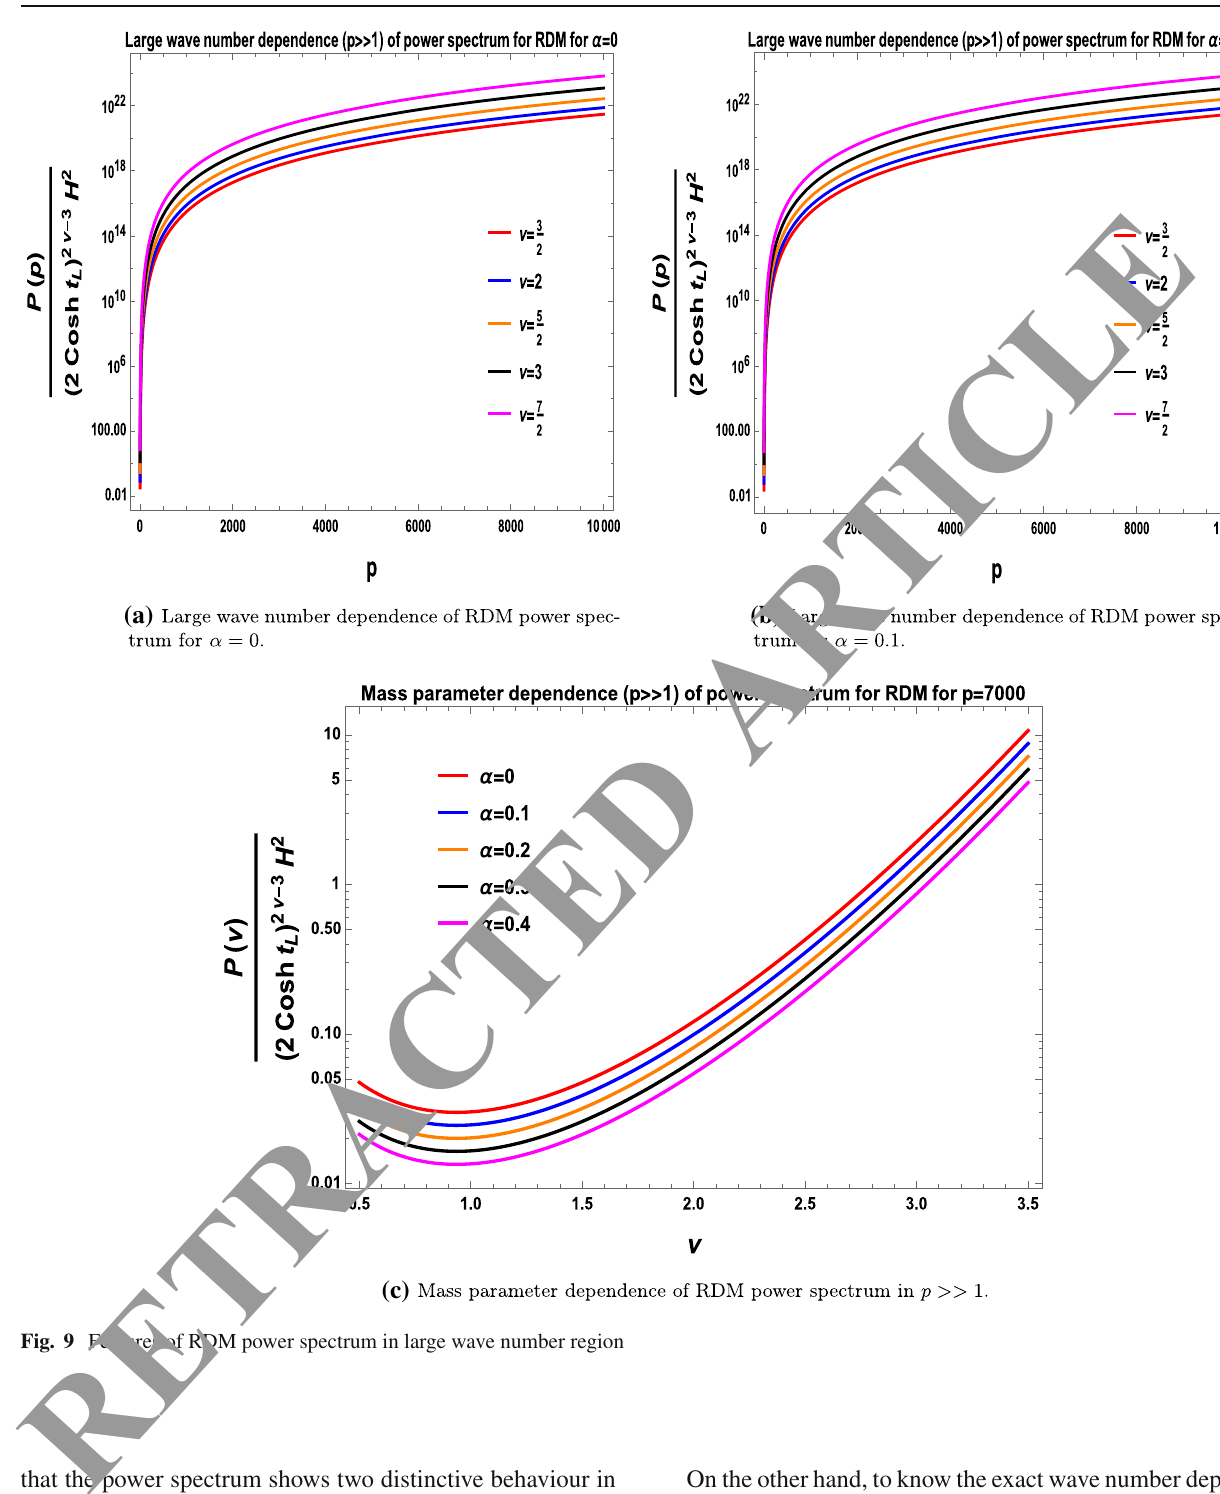
that the power spectrum shows two distinctive behaviour in 1 / 2 < ν < 1 and ν > 1 region. For 1 / 2 < ν < 1 region the amplitude of the power spectrum decrease to a certain value and just after ν = 1 it increases. Also note that in large wave number regime, the power spectrum obtained from RDM formalism behaves in the same as way as that obtained from FOE formalism in the previous